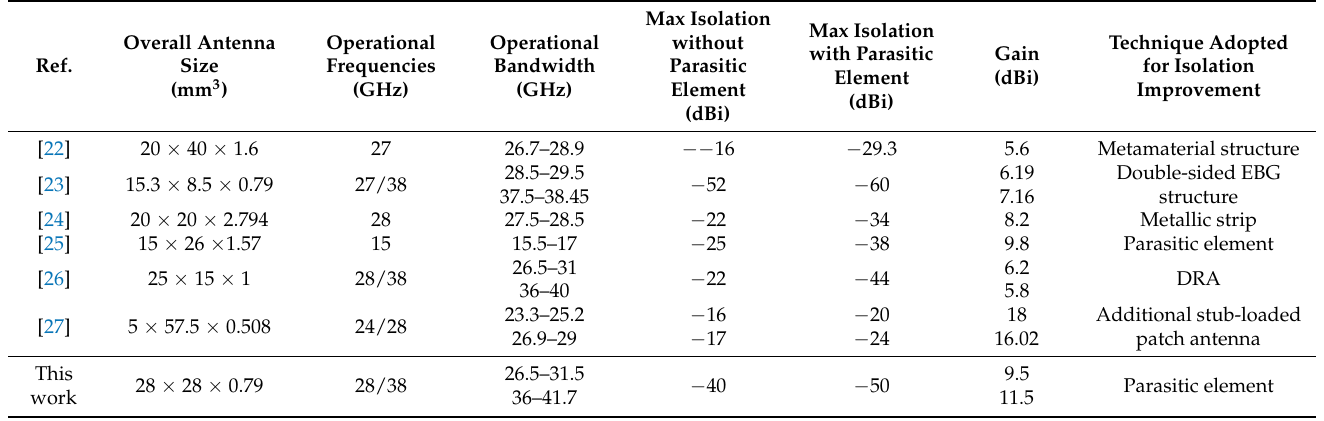
Table 2. Comparison of the proposed parasitic element-loaded MIMO antenna for isolation improve- ment with the state of the